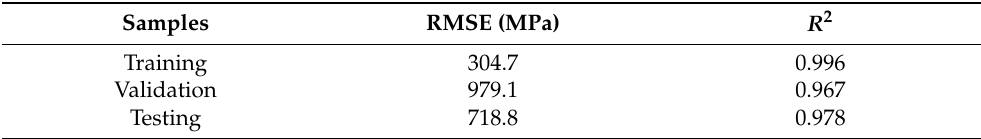
Figure 15. Cluster distribution pattern for the fiber diamond distribution model. ( a ) interface cluster; ( b ) matrix cluster; ( c ) fiber cluster. Table 4. Performance of the trained FFNN for fiber random distribution model.